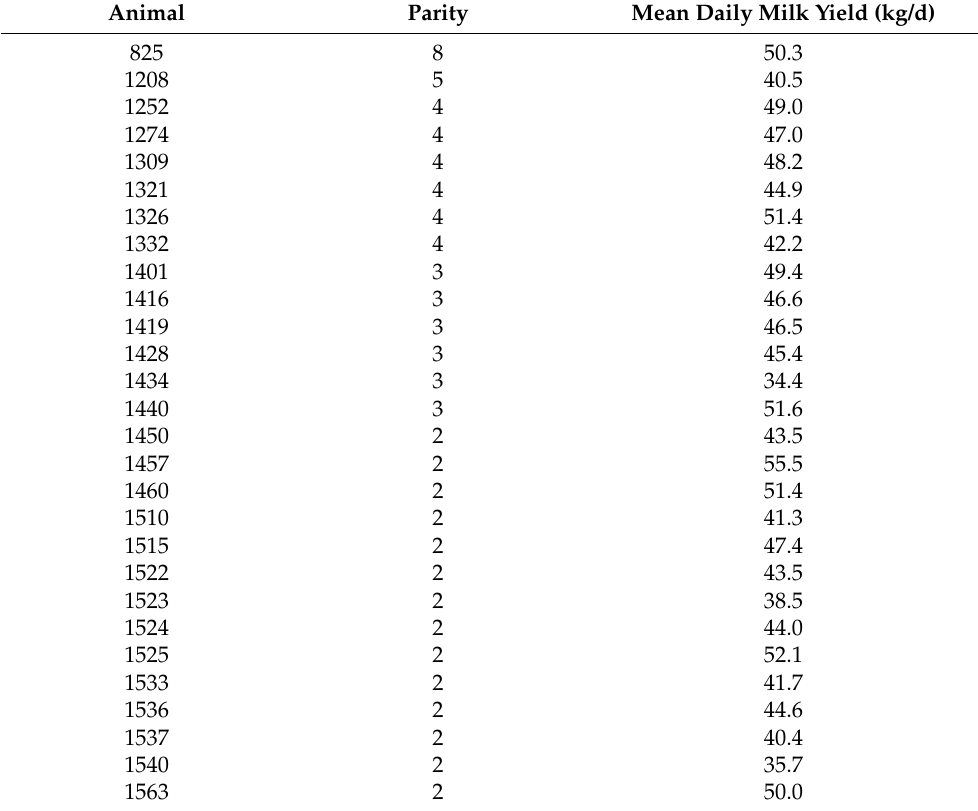
Table 1. Parity and mean daily milk yield (kg/d) of the trial cows between the 2nd and 15th week of